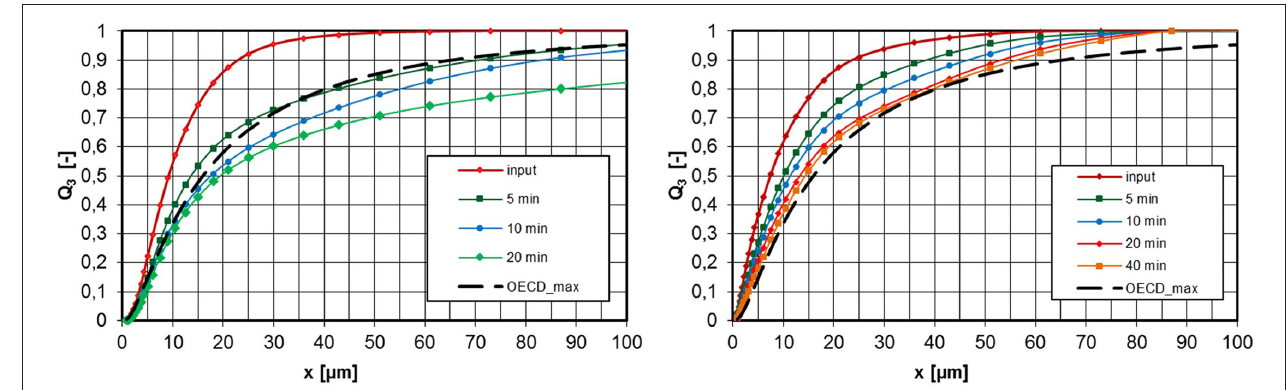
FIGURE 9 | PSD at the inlet and exhaust tube of the inhalation chamber for different operating times, HMDS surface-treated pyrogenic silica, ρ eff = 64 kg/m 3 (tamped density), left: c m = 5,100 mg/m 3 , right: 500 mg/m 3 .